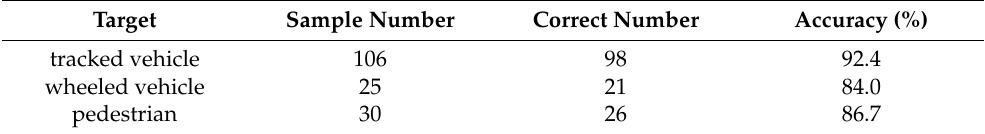
Table 4. Indoor recognition results.